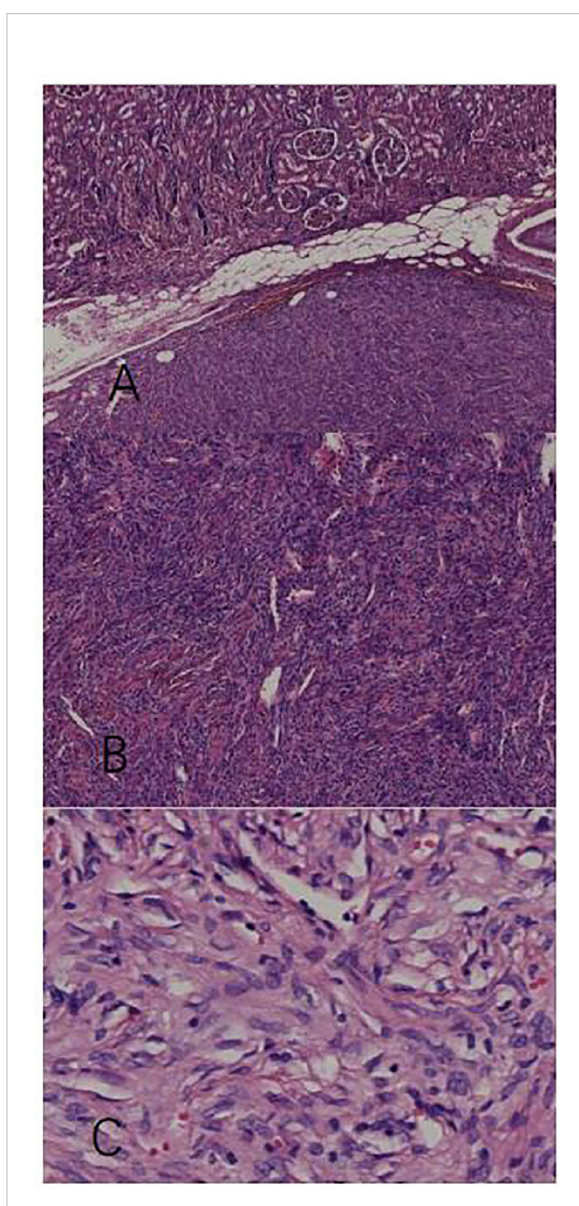
FIGURE 2 Pathological examination with hematoxylin-eosin stain. (A) The tumor tissue has a clear boundary with the intact parenchymal issue (x40). (B) The tumor tissue contains compactly arranged cells a nd blood vessels of different shapes (x100). (C) Spindle tumor cells row with benign patterns